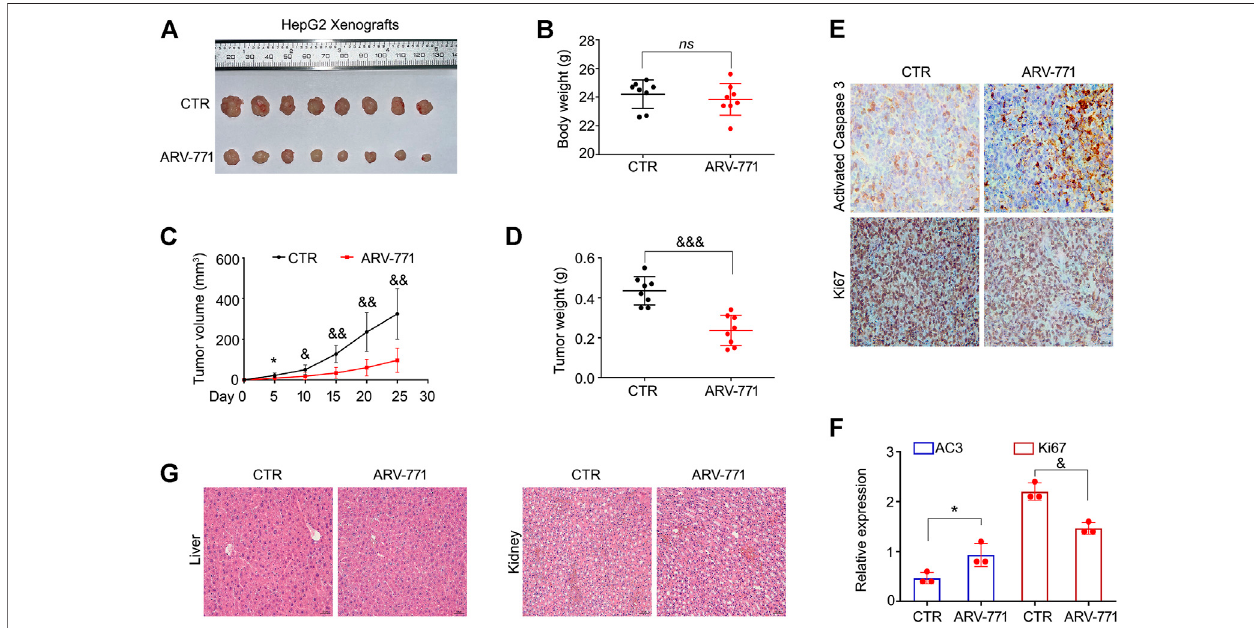
FIGURE 6 | ARV-771 inhibits HCC progression in nude mouse models. (A) HepG2 xenograft models were established and treated with ARV-771 or vehicle for 25 days. The xenograft image was shown. (B) Body weight of nude mice was shown. (C) – (D) Tumor volumes and tumor weight were quanti fi ed. (E) Immunohistochemistry assays were performed in xenograft tissues. Representative images of Ki67 and activated Caspase three were shown. (F) Quanti fi cation of the immunohistochemistry images was shown. AC3, activated Caspase 3. * p < 0.05, & p < 0.01 . (G) H&E staining assays were performed in liver and kidney tissues of nude mice. Representative images were